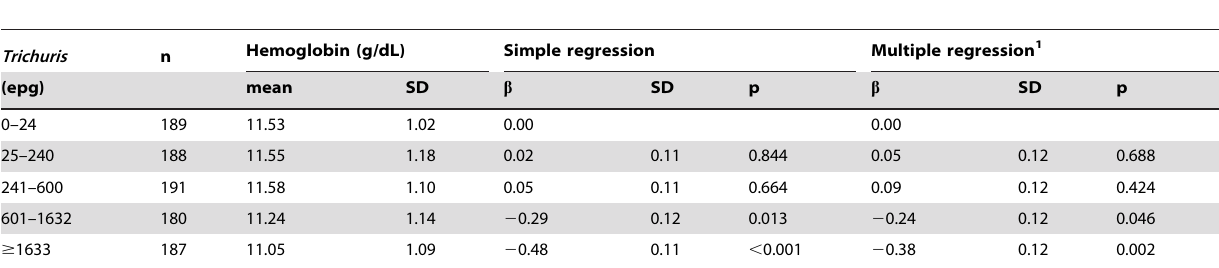
Table 1. Association between Trichuris infection in the second trimester and hemoglobin levels in the third trimester.